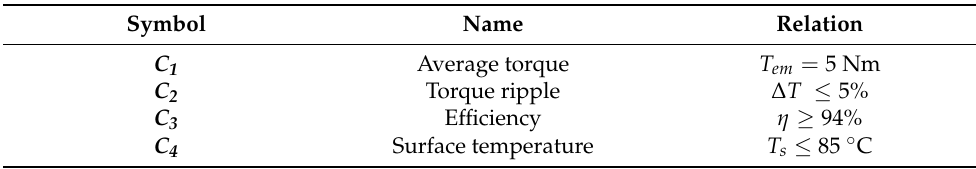
Table 2. Optimization